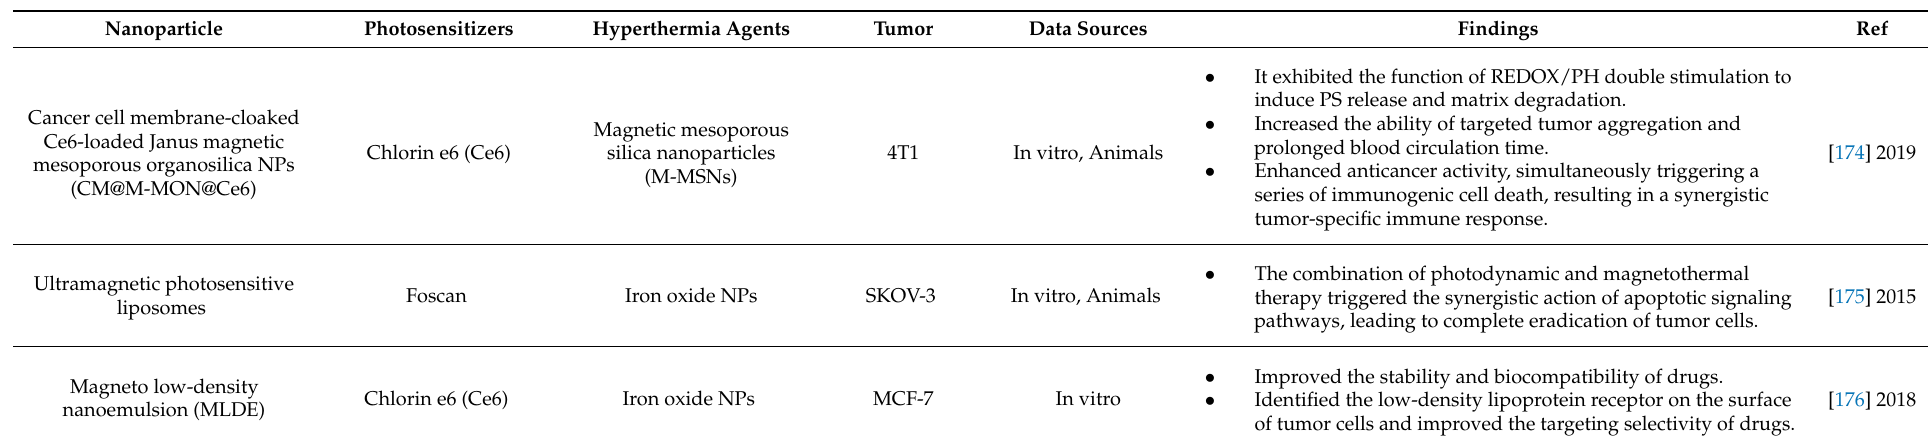
Table 5. Codelivery of photosensitizer and hyperthermia agent drugs based on